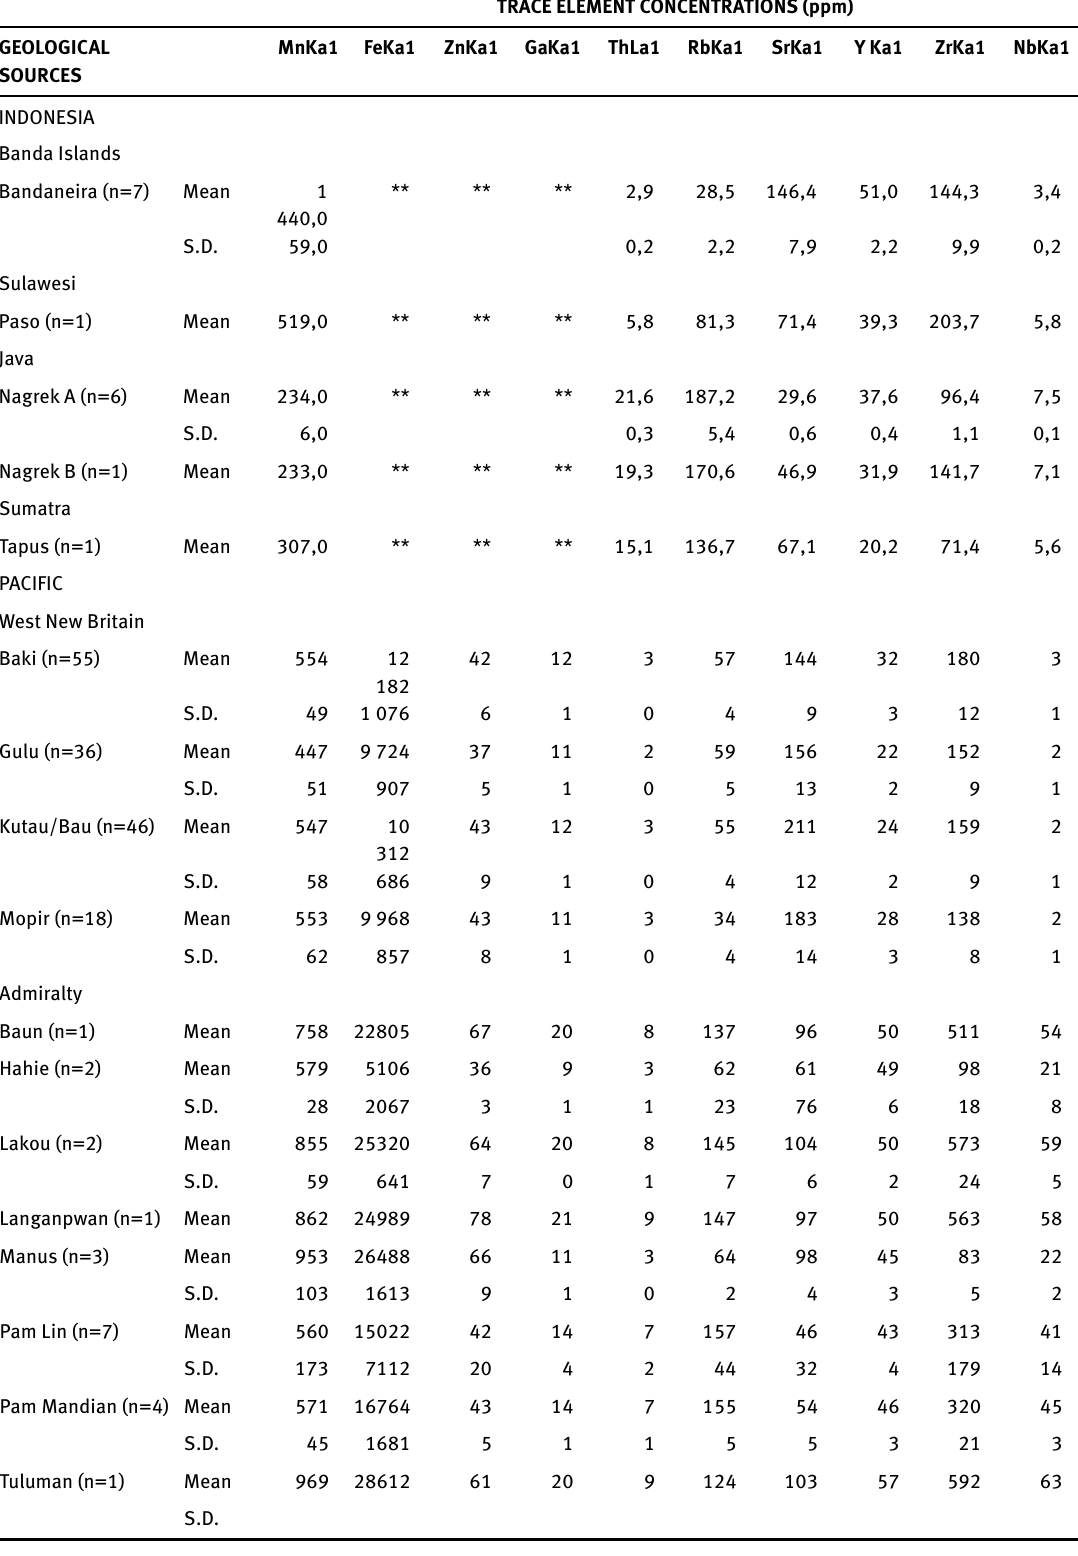
Table 4. Descriptive statistics of the known obsidian sources in Indonesia and the Pacific (Torrence et al., 2013; Reepmeyer et al.,